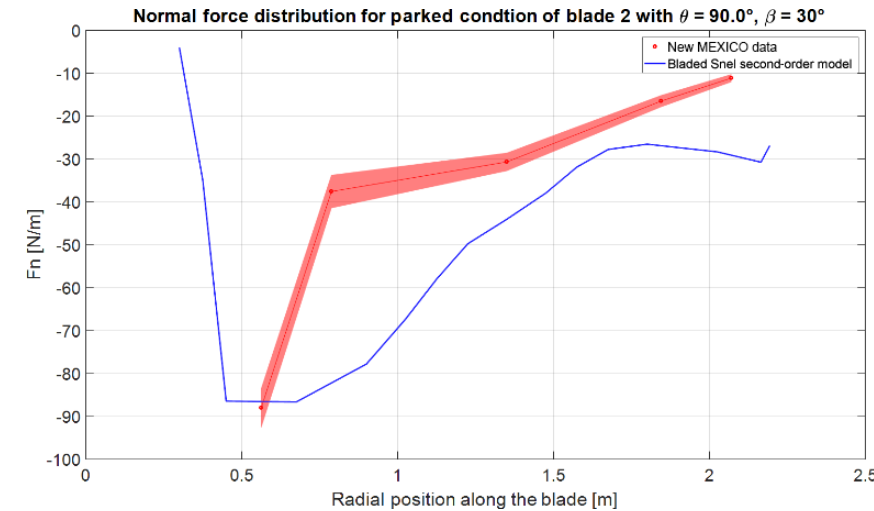
Figure 15. Normal force distribution of the blade at 120 ◦ azimuth with 90 ◦ pitch and 30 ◦ wind direction. The bold line represents the mean value and the shaded area the standard